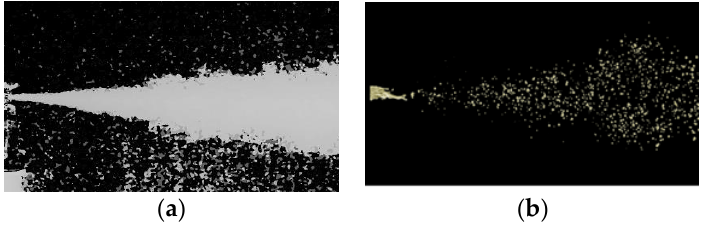
Figure 11. Atomization shape of air spraying. ( a ) Experimental measurement. ( b ) Numerical simulation.